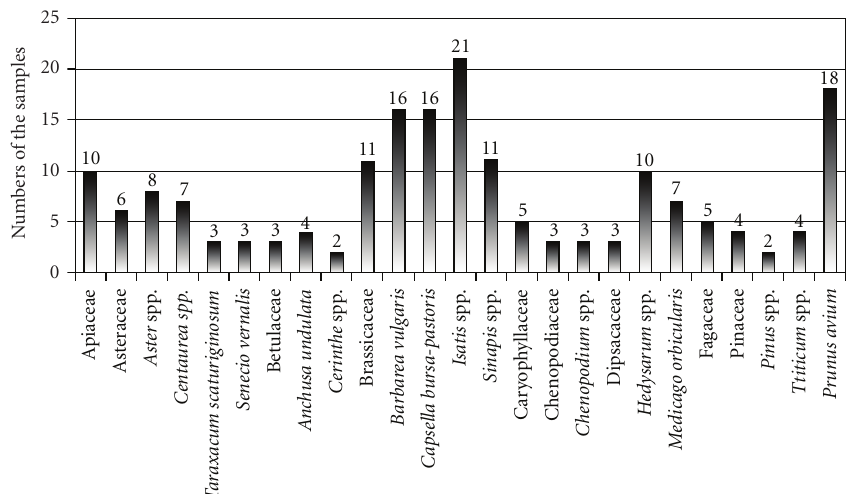
(1) Apiaceae (2) Asteraceae Aster spp. Centaurea spp. Senecio vernalis Waldst. & Kit. Taraxacum scaturiginosum G. Hagl. (3) Betulaceae (4) Boraginaceae Anchusa undulata L. Cerinthe spp. Barbarea vulgaris R. Br. Capsella bursa-pastoris (L.) Medik. Isatis